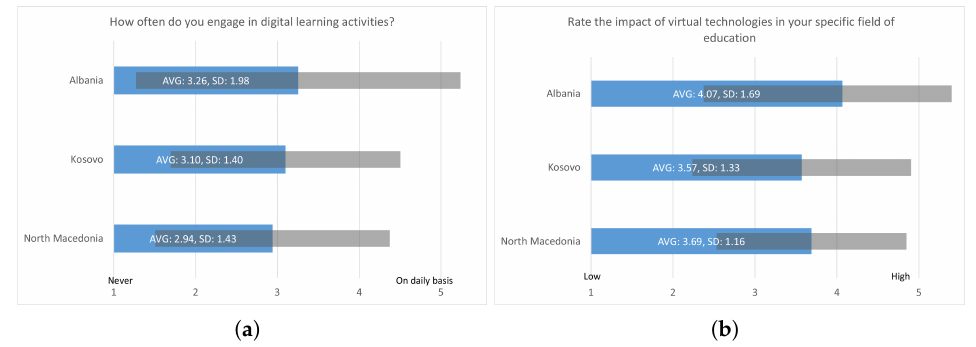
Figure 12. ( a ) Information regarding VR technologies in schools. ( b ) Students’ feedback about implementation of VR technologies in the learning process.